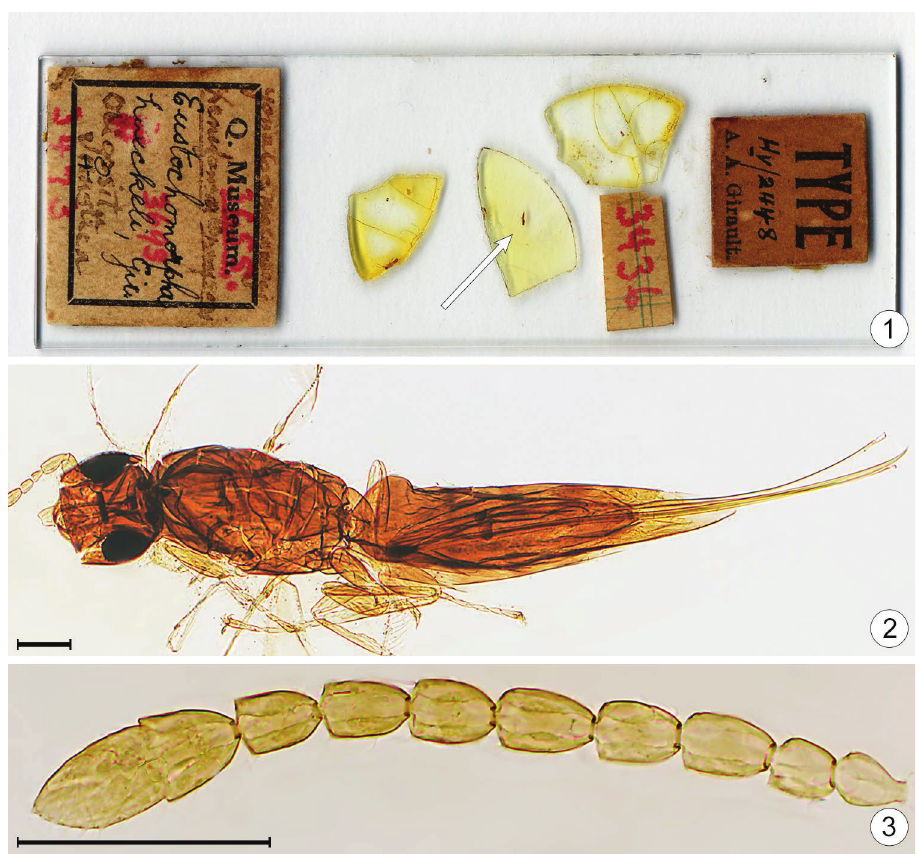
Figures 1–3. Eustochomorpha haeckeli , holotype female. 1 type slide, specimen under middle cover slip 2 body + legs 3 antenna. Scale bar = 100